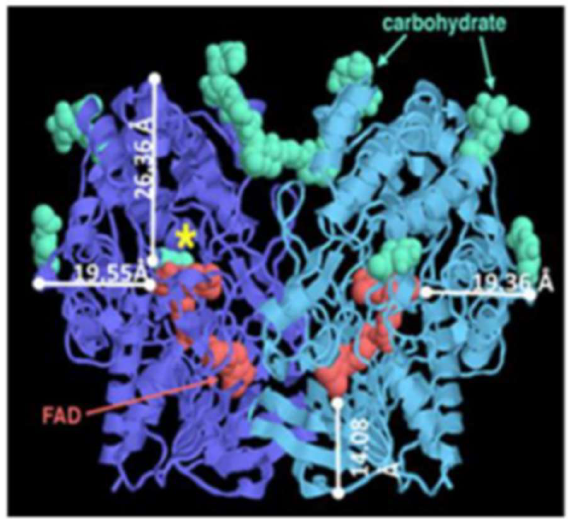
Figure 4. Gox structure with FAD co-factors bound deep inside the enzyme red color. Reprinted with permission from ref. [91]; Copyright 2012 Elsevier.